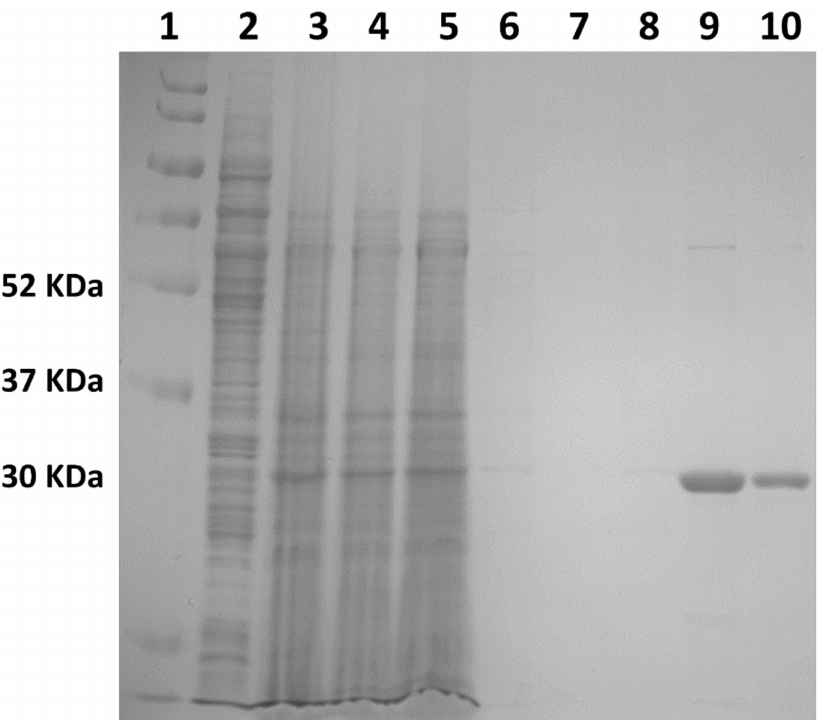
Figure 3. SDS–Page, from left to right: 1, protein ladder; 2, supernatant; 3, pellet; 4, load; 5, flow– through; 6 and 7, wash 1 and 2; 8, 9 and 10, elution fractions E1, E2 and E3,